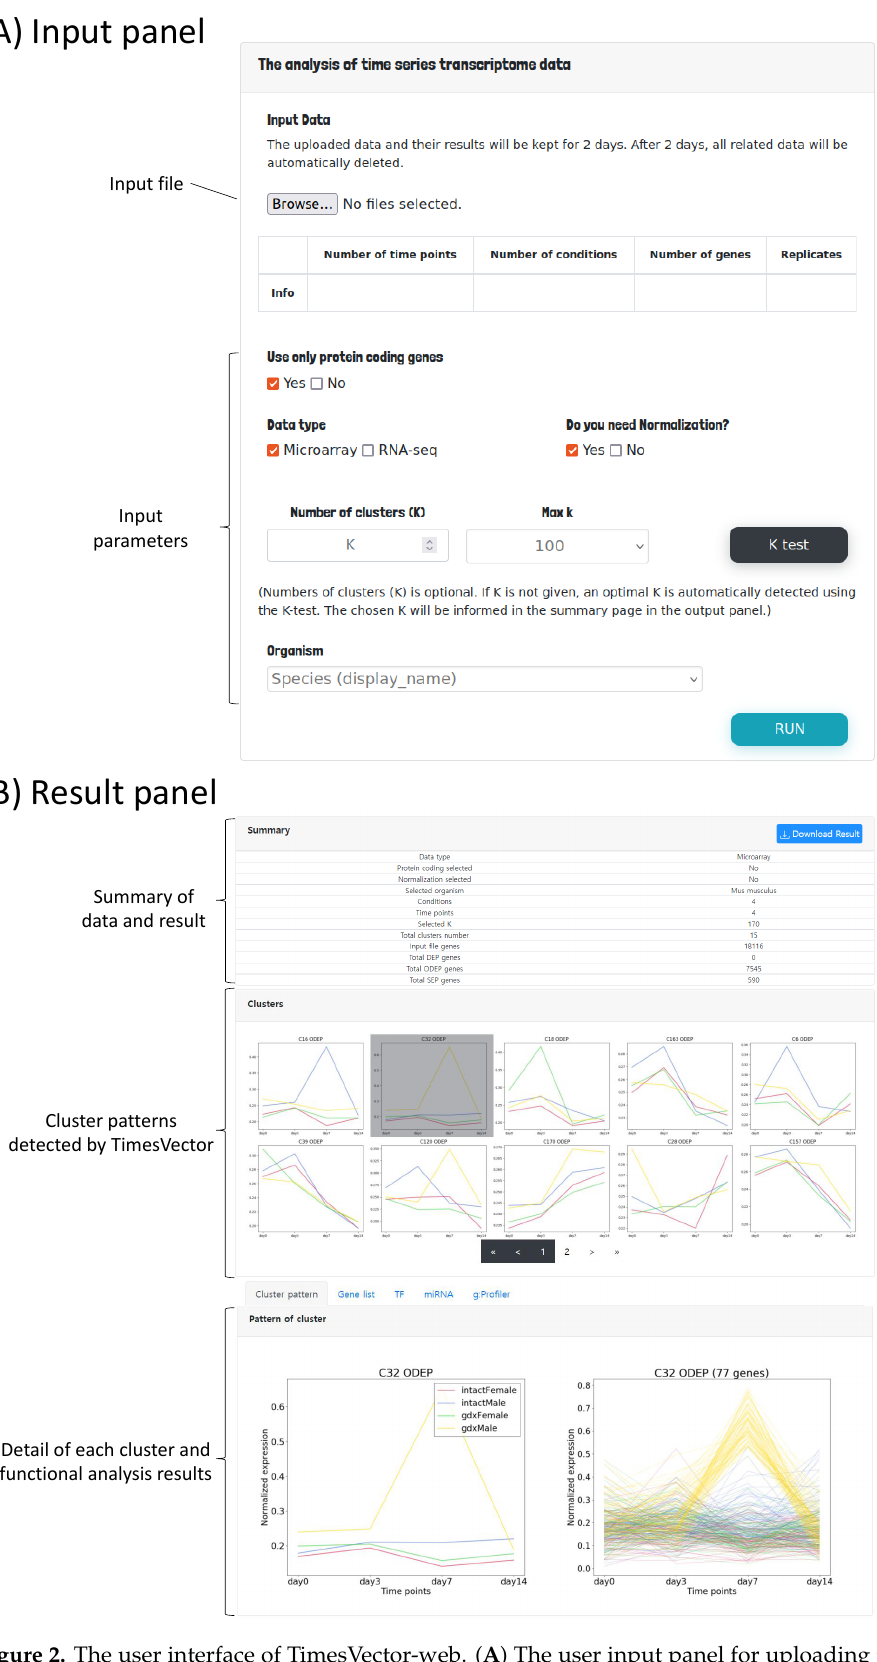
Figure 2. The user interface of TimesVector-web. ( A ) The user input panel for uploading the time course gene expression data and setting input parameters. ( B ) The results panel for viewing the clustering results and performing downstream biological functional